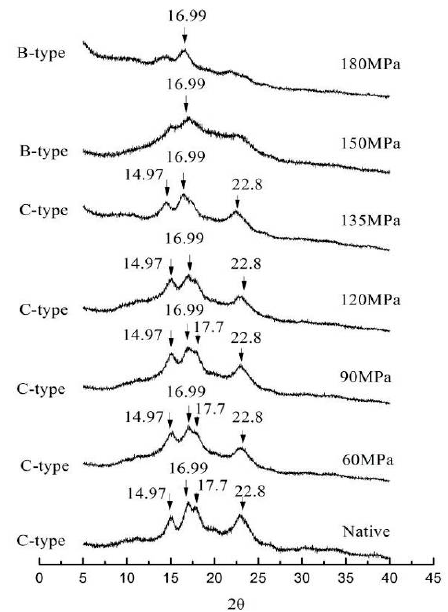
Figure 1. X-ray powder diffraction patterns of native and pressurized lotus seed starch.